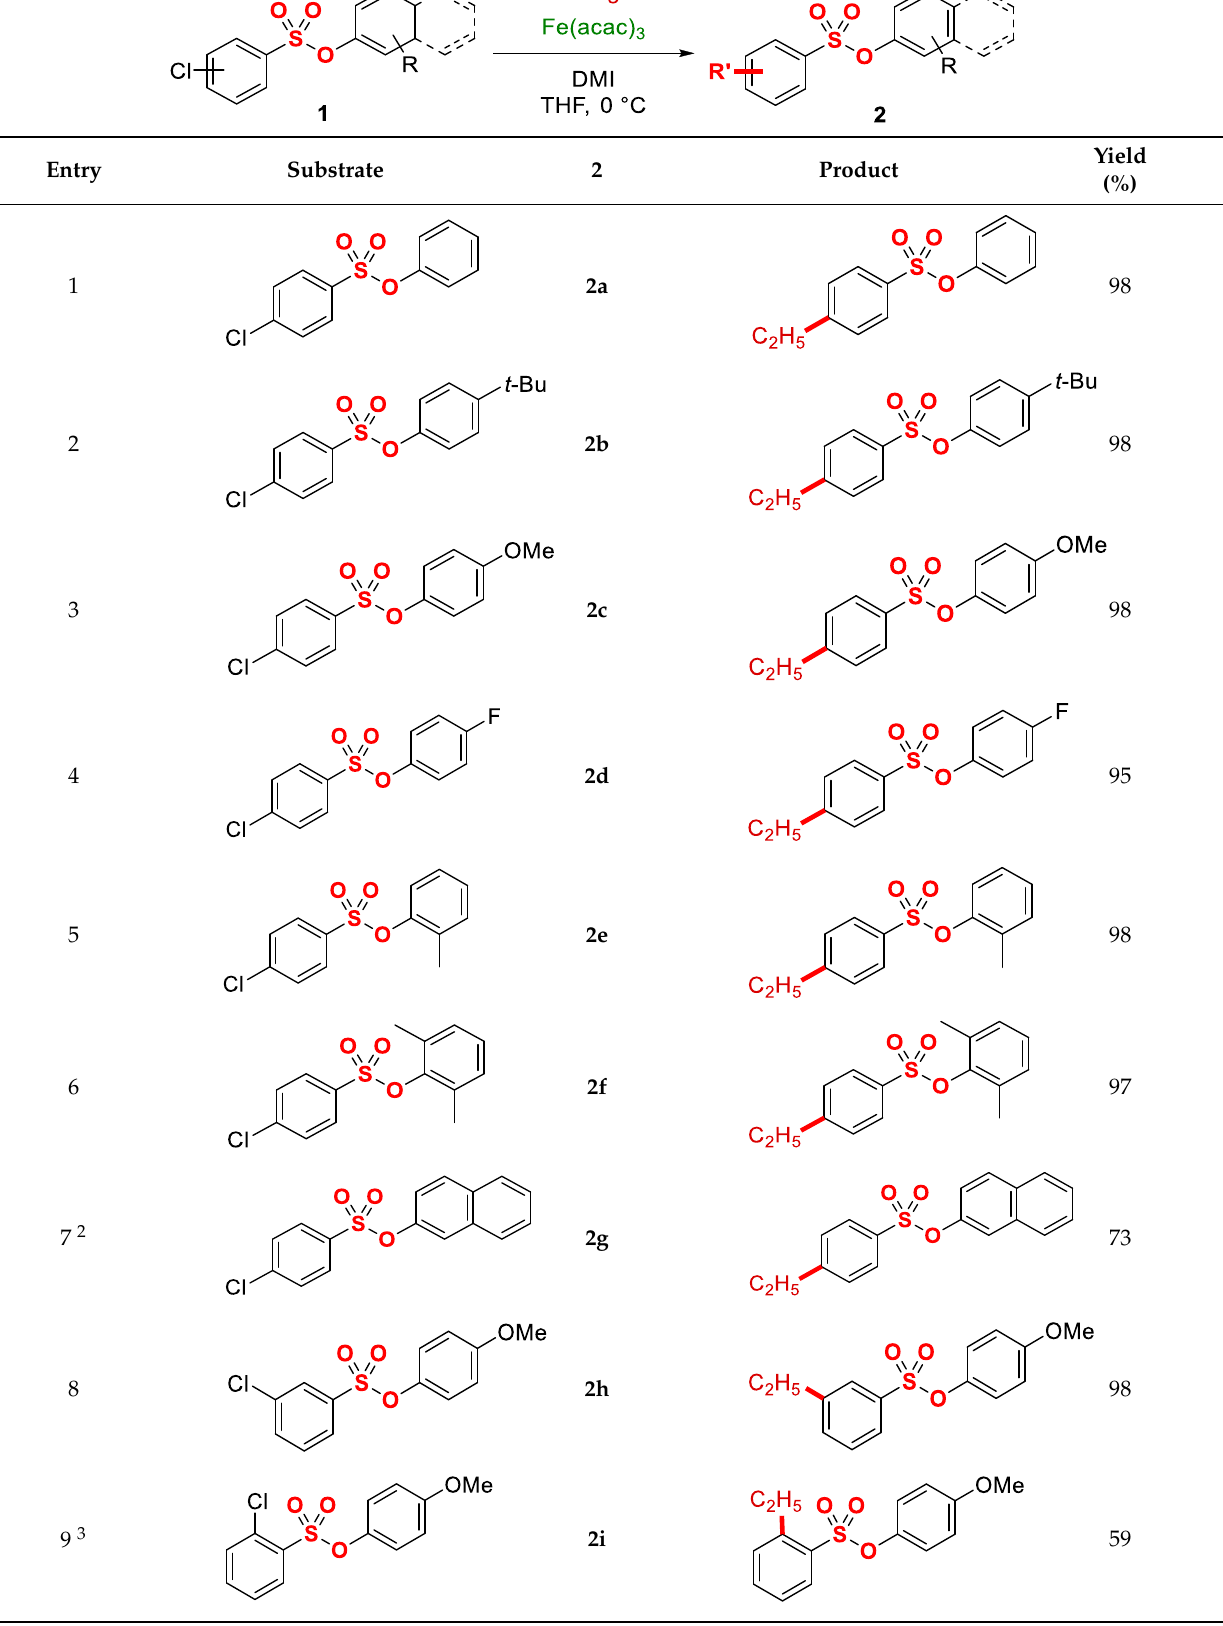
Table 2. Iron-catalyzed C(sp 2 ) – C(sp 3 ) cross-coupling of aryl chlorobenzenesulfonates with alkyl Grignard reagents 1 .